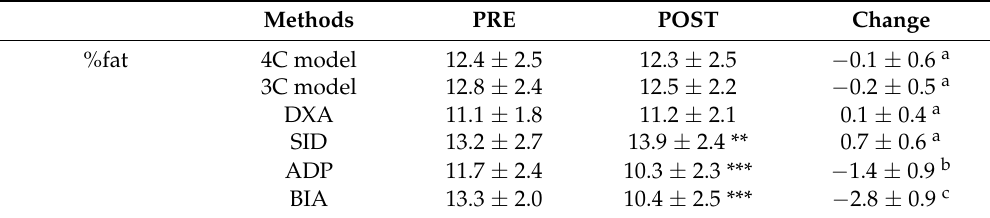
Table 2. Differences in body composition changes per method